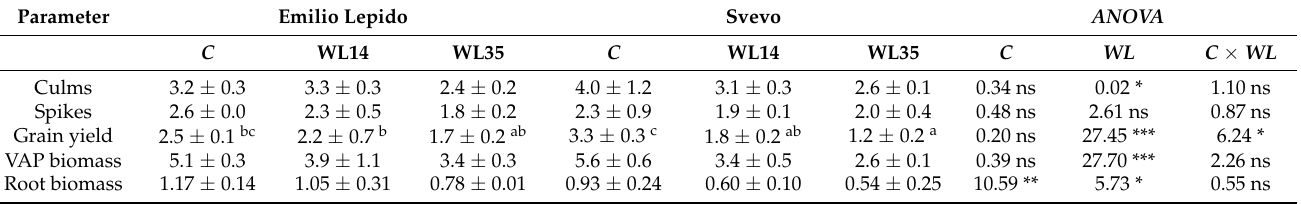
Table 3. Number of culms and spikes per plant (n plant − 1 ), grain yield (g plant − 1 ), and the vegetative above-ground part (VAP) and root biomass (g dry weight plant − 1 ) of the durum wheat cultivars Emilio Lepido and Svevo at maturity (125 days from the beginning of waterlogging), and previously subjected to 0, 14, or 35 days of waterlogging (C, WL14 and WL35, respectively). F values and p levels (***: p ≤ 0.001, **: p ≤ 0.01, *: p ≤ 0.05, ns: p > 0.05) of the two-way analysis of variance (ANOVA) for the effects of cultivar ( C ; degrees of freedom, df: 1), waterlogging ( WL ; df: 2), and their interaction ( C × WL ; df: 2) are shown. In case two-way ANOVA reveals a significant C × WL interactive effect on the specific parameter, according to Tukey’s post hoc test, different letters indicate significant differences among means ( p ≤ 0.05).